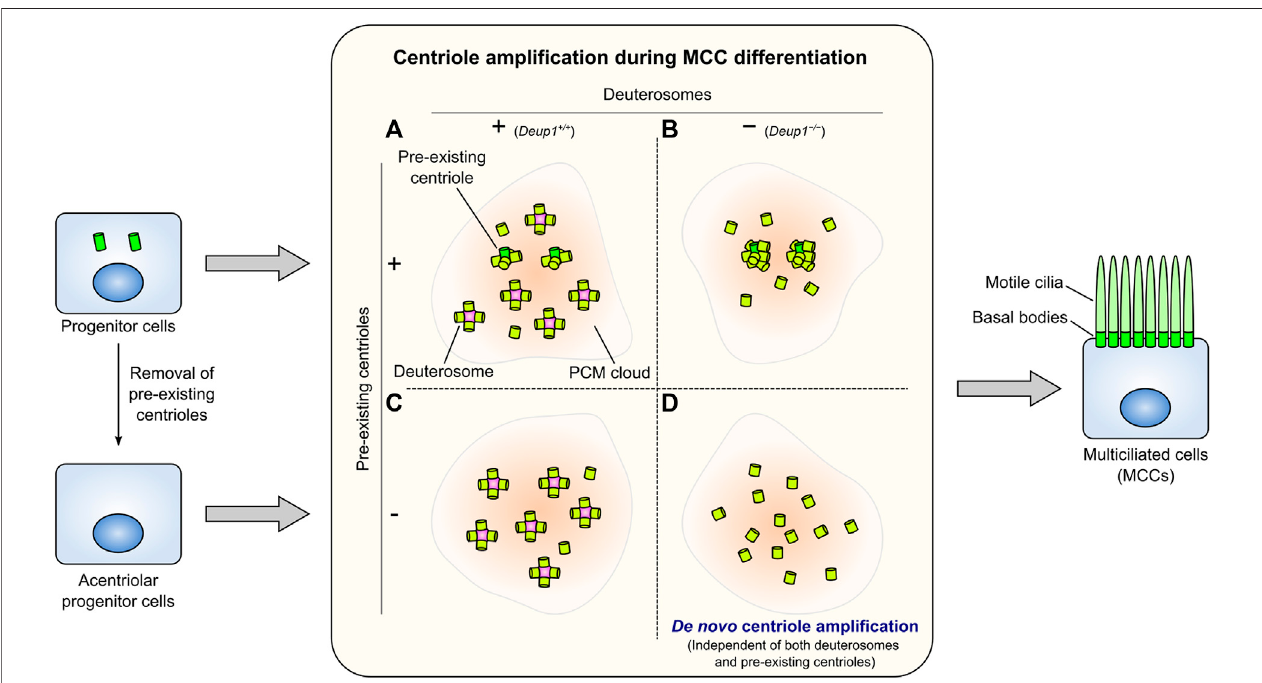
FIGURE 4 | Centriole ampli fi cation in multiciliated cells (MCCs). Numerous centrioles assemble from the pre-existing centrioles and many deuterosomes in intact wild-type MCCs (A) . Deup1 − / − MCCs, which cannot form deuterosomes, assemble more centrioles from the pre-existing centrioles (B) . In MCCs whose pre-existing centrioles have been removed, centrioles form predominantly through the deuterosome-dependent pathway (C) . MCCs can amplify the proper number of centrioles de novo withoutthepre-existingcentriolesanddeuterosomes (D) .Centrioleampli fi cationoccurspresumablywithinaPCMcloudineachcondition.Thesecentriolesin each case dock at the plasma membrane and serve as basal bodies to form numerous motile cilia